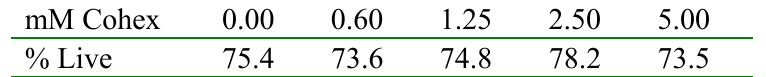
Table 1. Typical flow cytometry results for uninfected BHK